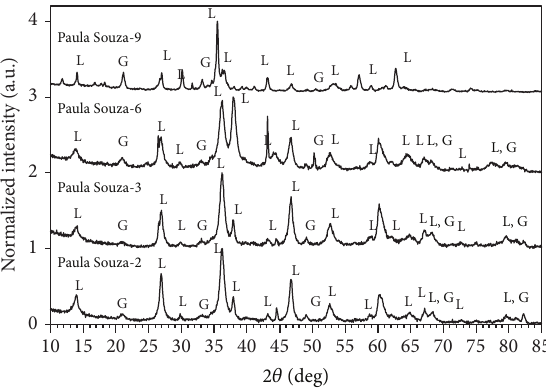
Figure 6: XRD patterns of specimens exposed in Paula Souza station for different periods. G = goethite; L = lepidocrocite.